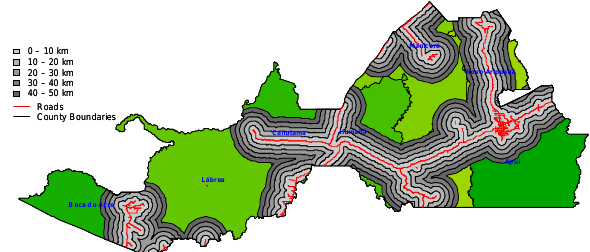
Figure 2. Accessibility map (a map of the distance from the nearest